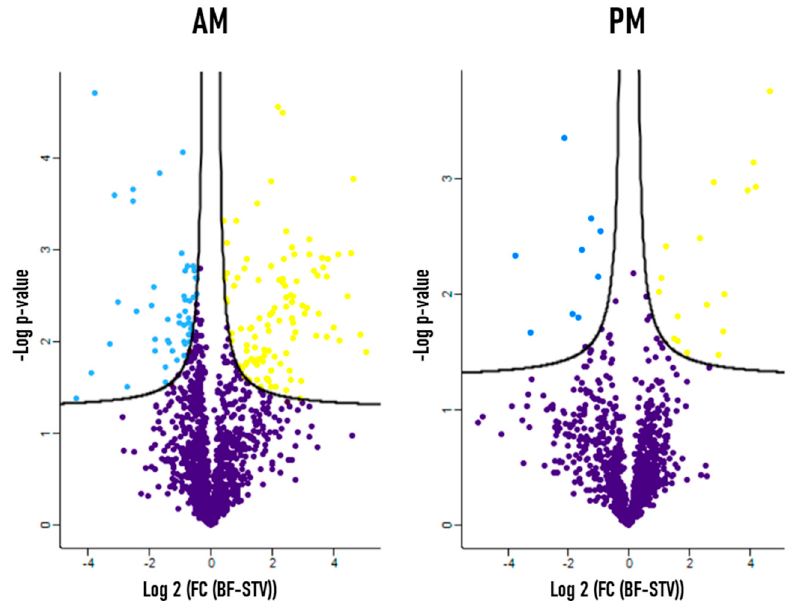
Figure 1. Volcano plot comparing the normalized expression of proteins in R. prolixus anterior midgut (AM) (left) and posterior midgut (PM) (right) between starved and 6 h post blood feeding conditions. y -axis: negative log of p -value; x -axis: log2-transformed fold-change; yellow dots: up-regulated proteins with significant p -value; blue dots: down-regulated proteins with significant p -value; purple dots below the significance lines: non-variable proteins. Differentially expressed proteins were determined by Student’s t -test ( p ≤ 0.05) and FC ≥ 2.